Question: Does the figure show an increasing or a decreasing trend?
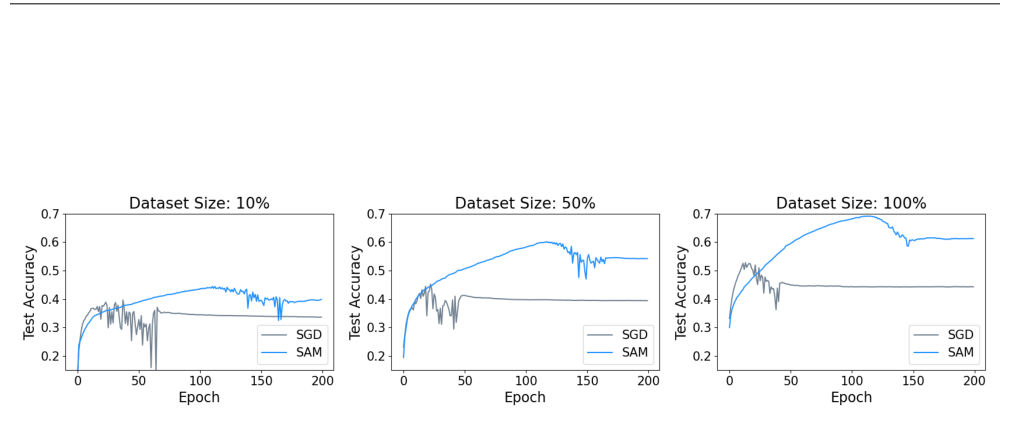
Answer: increasing